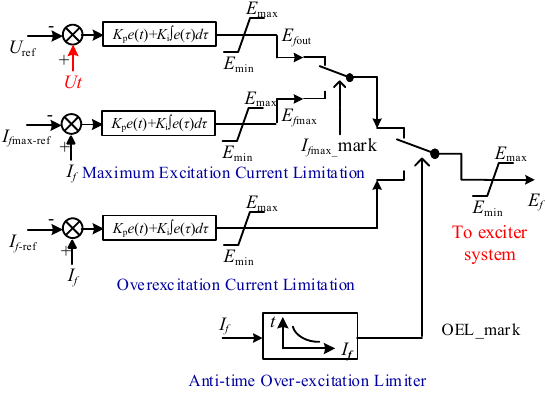
Figure 3. Control mechanism for the synchronous condenser.